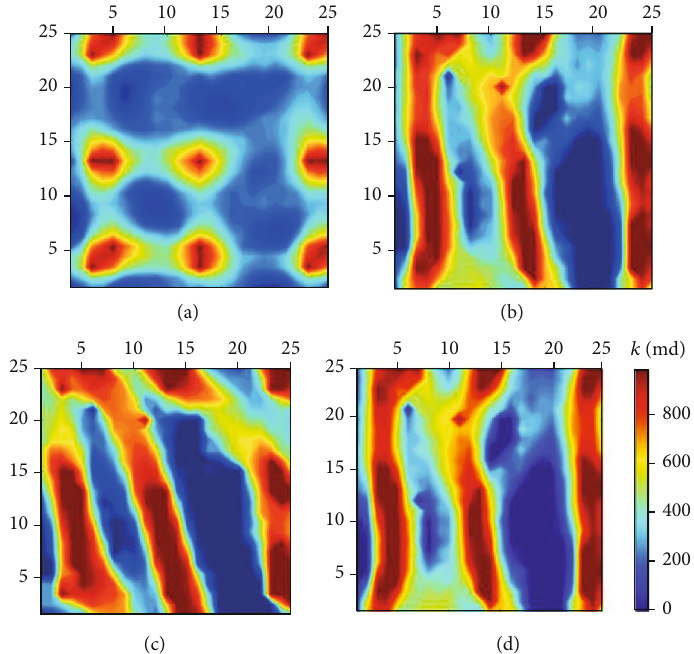
Figure 14: The mean of permeability models for (a) 800 initial models; 100 models regenerated by (b) SVM, (c) ANN, and (d)